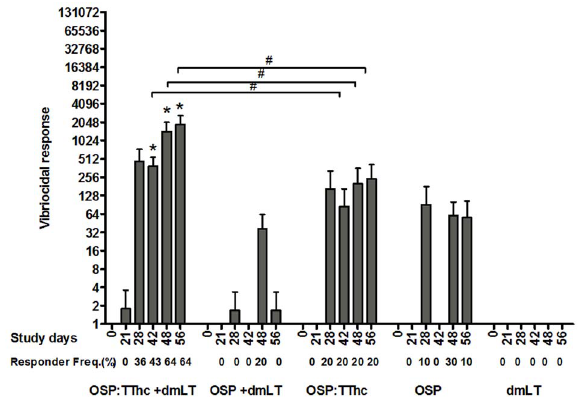
Figure 4. Vibriocidal responses in mice intramuscularly immu- nized with OSP:TThc (with dmLT), OSP (with dmLT), OSP:TThc (no dmLT), OSP (no dmLT), or dmLT alone. The columns indicate mean reciprocal end titers, and error bars represent the standard errors of the mean. An asterisk denotes a statistically significant difference ( P , 0.05) from baseline (day 0) titer. Responder frequencies are also listed. # , statistically significant difference among the vaccine cohorts ( P , 0.05).